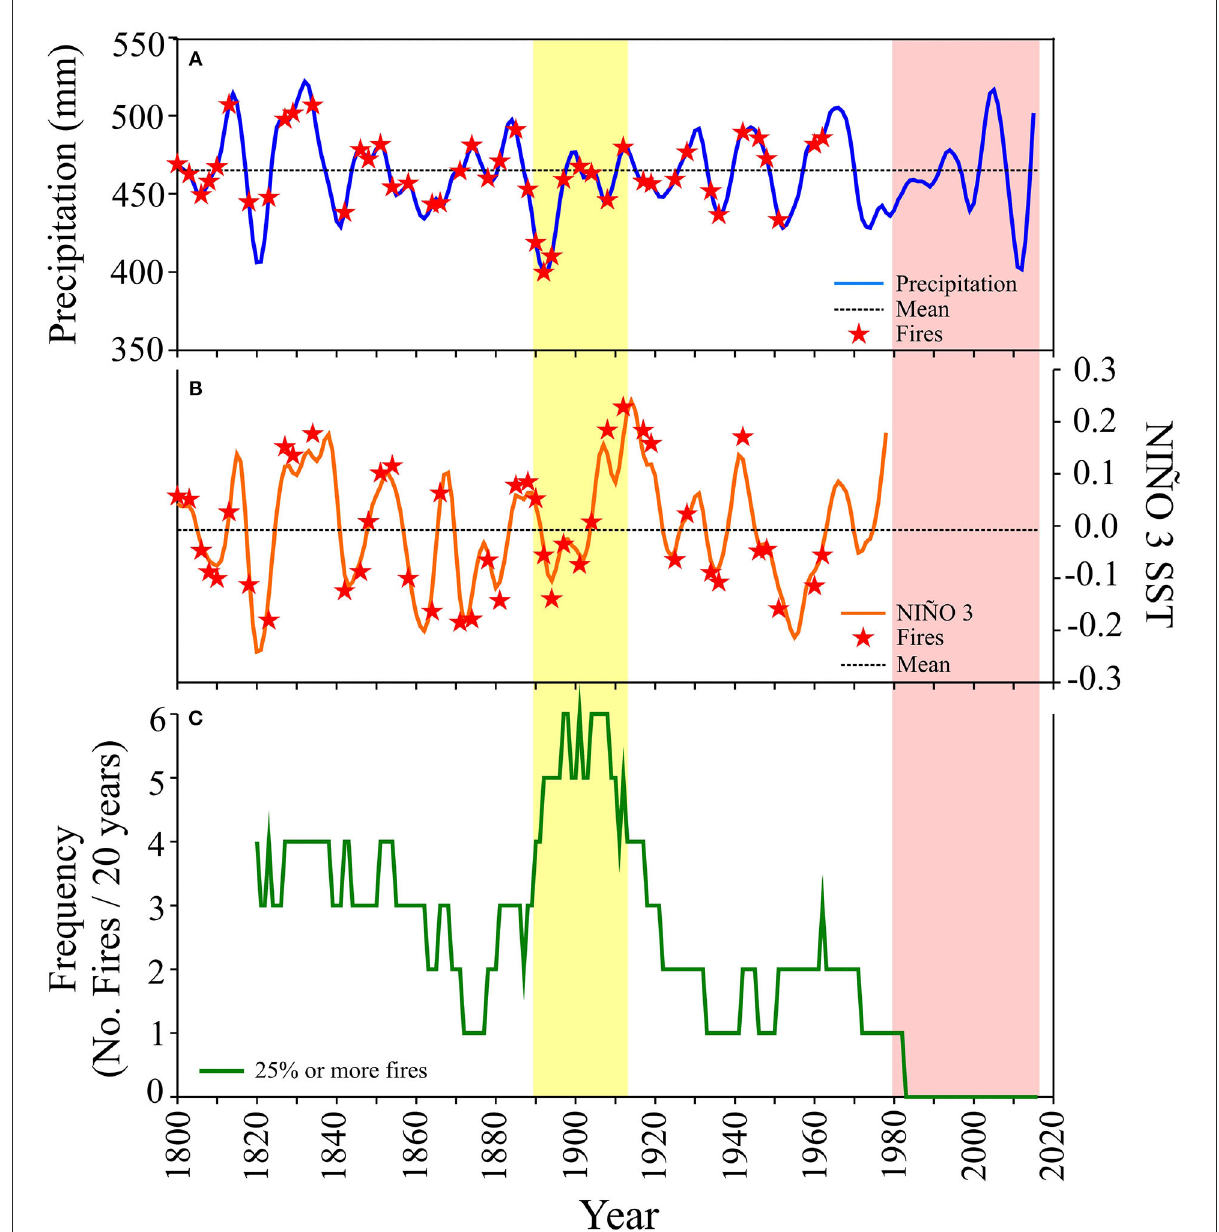
FIGURE4 Spring-winter precipitation and NIÑO 3 SST condition in relation to fire frequencies within a Pinus lumholtzii sire in the Sierra Madre Occidental of northern Mexico. Tree-ring recorded fire years are identified by red stars and occur mainly during year with low precipitation (A) (Chávez-Gándara et al., 2017) and negative NIÑO 3 SST (B) (Cook, 2000), based on tree ring reconstructed of climate variables. Fire frequency is measured using a 20-year moving average based on fire years recorded by 25% or more of the fire-scarred trees (C) . Yellow-highlighted area corresponds to a period of synchrony between drought conditions and high fire frequency and while a more recent period with no extensive fires in recent decades is highlighted in pink.